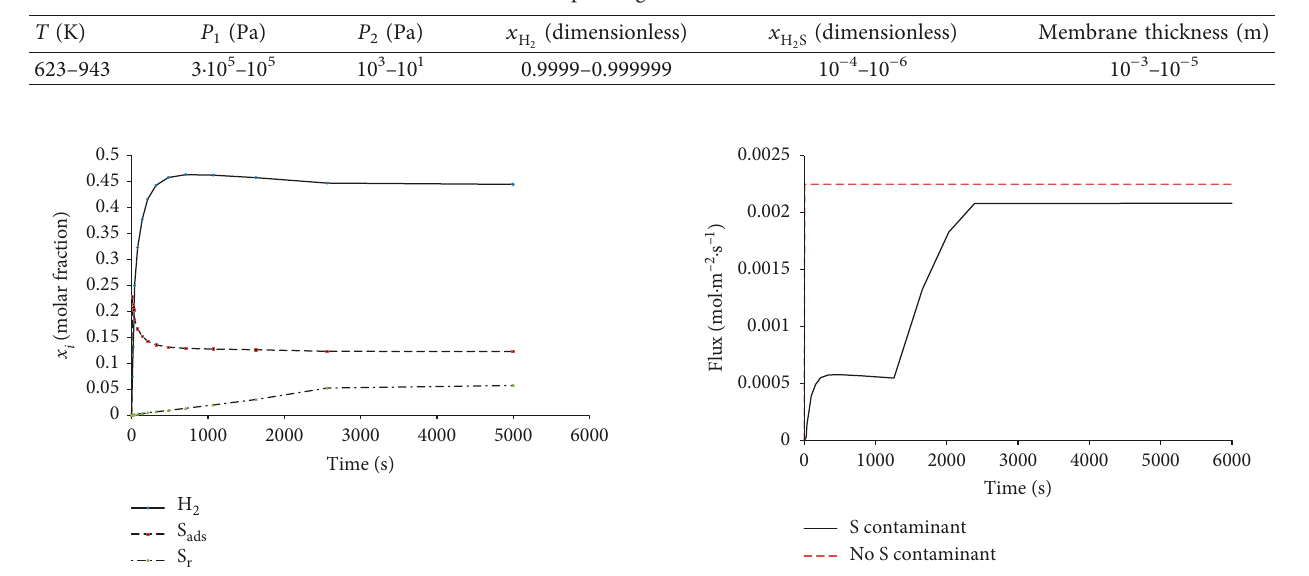
Table 3: Standard operating data used in the simulations.